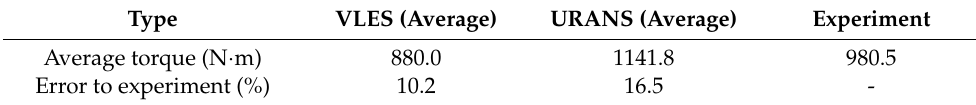
Table 5. Comparison of CFD torque values with experimental data (wind speed = 10 m/s).